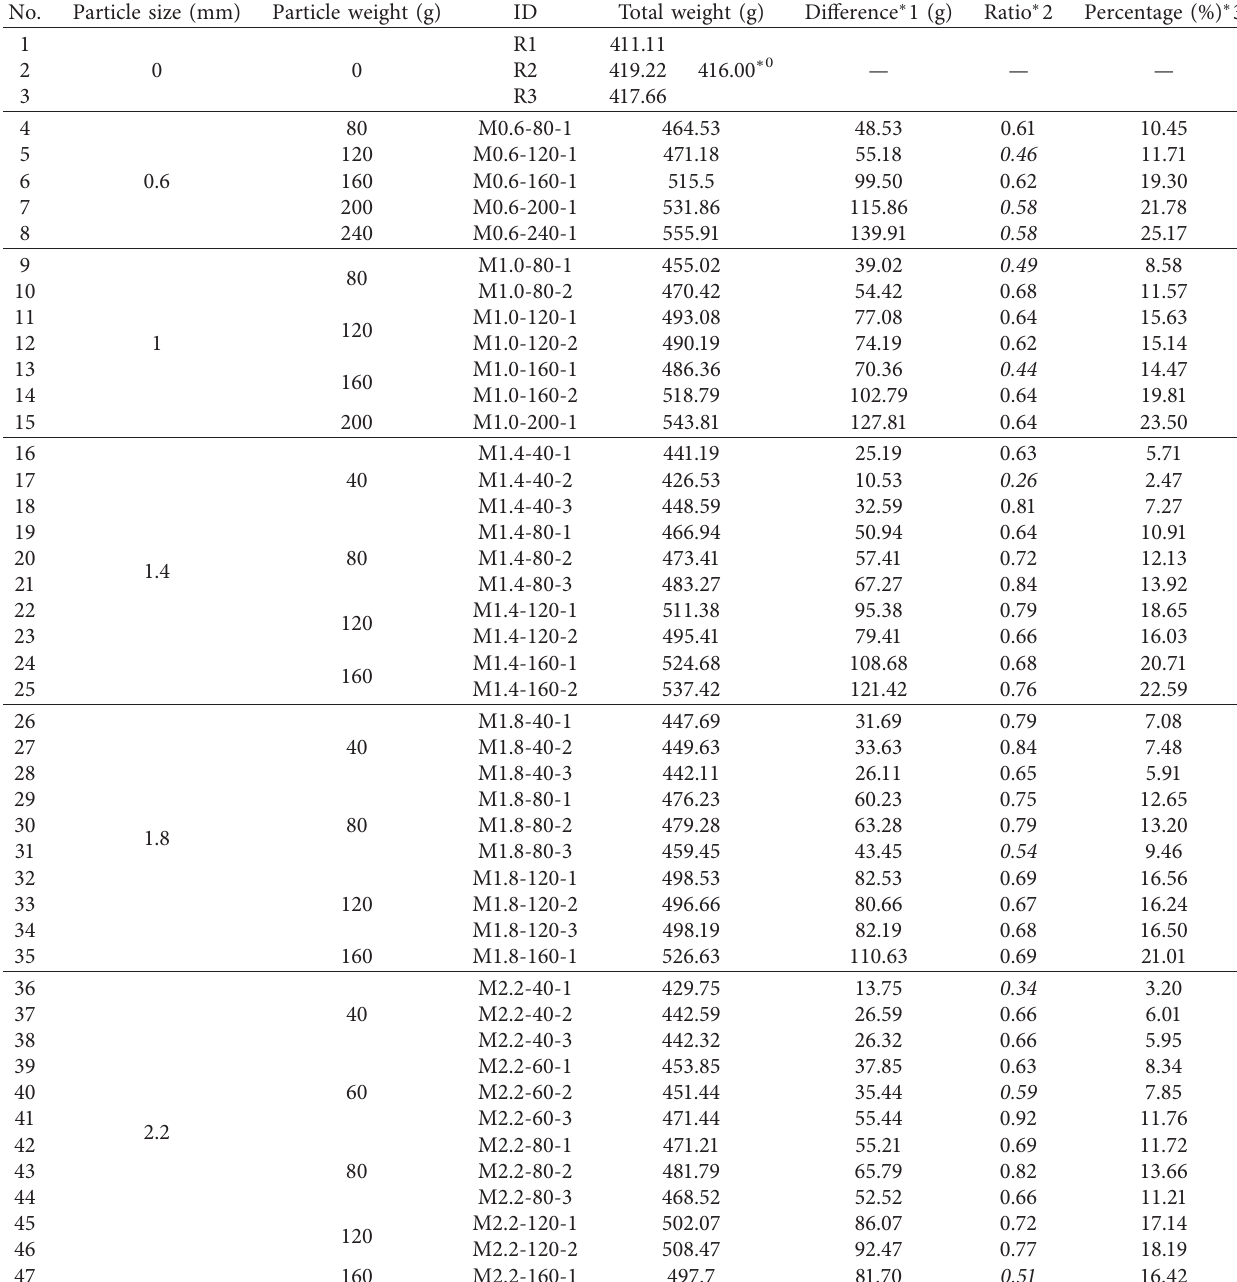
Table 1: Critical parameters of the prepared